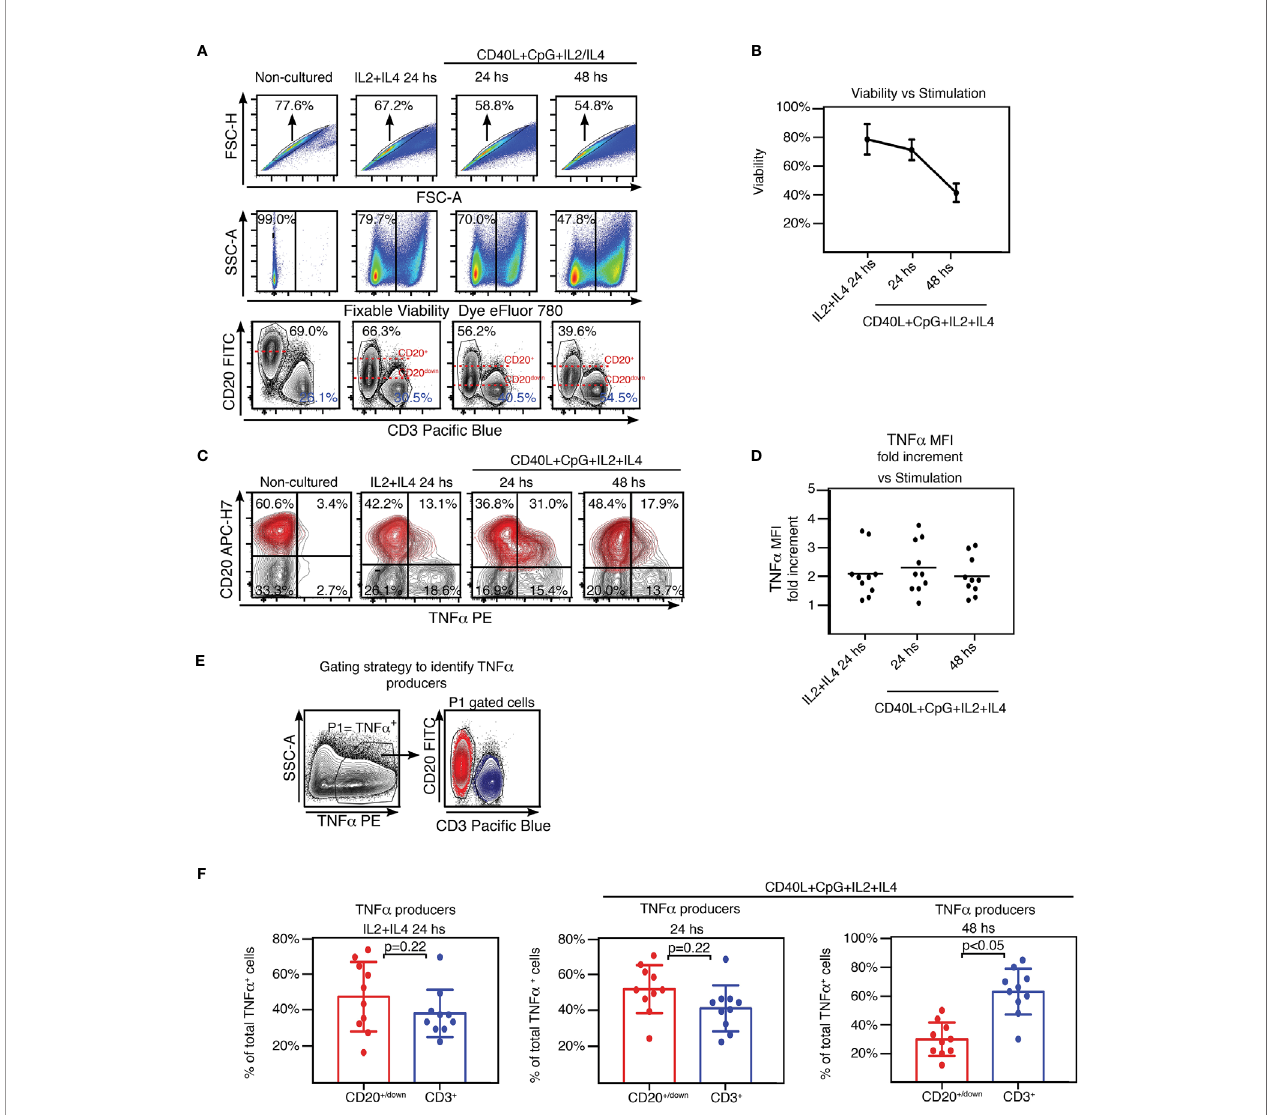
FIGURE 1 | TNF a expression by tonsillar mononuclear cells. (A) Freshly isolated TMC were cultured on IL2+IL4 alone or CpG+CD40L+IL2+IL4, for the time points indicated on the top of each panel. Non-cultured cells served as control (conserved at 4 0 C). Cells were stained for surface CD20, CD3 and intracellular TNF a . Samples were subsequently analyzed by FACS. Gating strategy is partially illustrated. Singlets were gated by plotting FSC-H vs FSC-A for each sample (upper panels). Within the singlets population, dead cells were determined by a fi xable viability dye. In this case, the viable gate corresponds to the eFluor 780 - cells (middle panels). Within the viable gate, lymphoid gate was determined through SSC-A vs FSC-A (not shown). Lower panels: CD20 vs CD3 contour plots. Percentages designate frequencies of the populations indicated. Dashed red lines show the decline of expression of CD20 post stimulation. Data from one experiment representative of 10 independent experiments performed with different individuals each one, are presented. Gates were manually adjusted due to the changes experienced by the cells in culture upon each treatment. (B) Line graph plotting the mean percentage ± SD of the frequencies of the viable gate pooled from the 10 independent experiments performed with stimulated TMC and detailed in (A) . (C) TMC were cultured under the same conditions and stained for the same molecules as in (A) . Gating strategy as in (A) (singlets-viable-lymphoid, not shown). Contour plots show TNF a and CD20 expression by TMC. Percentages designate frequencies of populations in each quadrant. CD20 +/down cells appear highlighted in red, based on the gating performed on the corresponding CD20 vs CD3 graph as in (A) , using the backgating option, to exclude any CD3 contamination. Quadrants were manually adjusted due to the changes experienced by the cells in culture upon each treatment. Data from one experiment representative of 10 independent experiments performed with different individuals each one, are presented. (D) Graph showing the MFI fold increment=(TNF a MFI of CD3 + TNF a + /TNF a MFI of CD20 +/down TNF a + ) for each independent experiment at every stimulating condition. Calculations were made following FACS analysis depicted in Supplementary Figure 4 . (E) Gating strategy used to estimate B and T cell speci fi c contribution to the TNF a + cell pool from the 10 samples analyzed as shown in (A – C) . P1 denotes percentage of TNF a + cell population determined by TNF a vs SSC- A contour pro fi le under the stimulations described above. Panel on the right, representative contour plots for CD20+/down (red) and CD3 + (blue) populations within the P1 gate. (F) Histograms presenting the mean percentage ± SD of the CD3 + and CD20 down/+ cell population frequencies from 10 independent experiments within the TNF a + cell pool for each stimulating condition, calculated as shown in (E) p value was calculated through unpaired t test, normality was con fi rmed by the Shapiro-Wilk